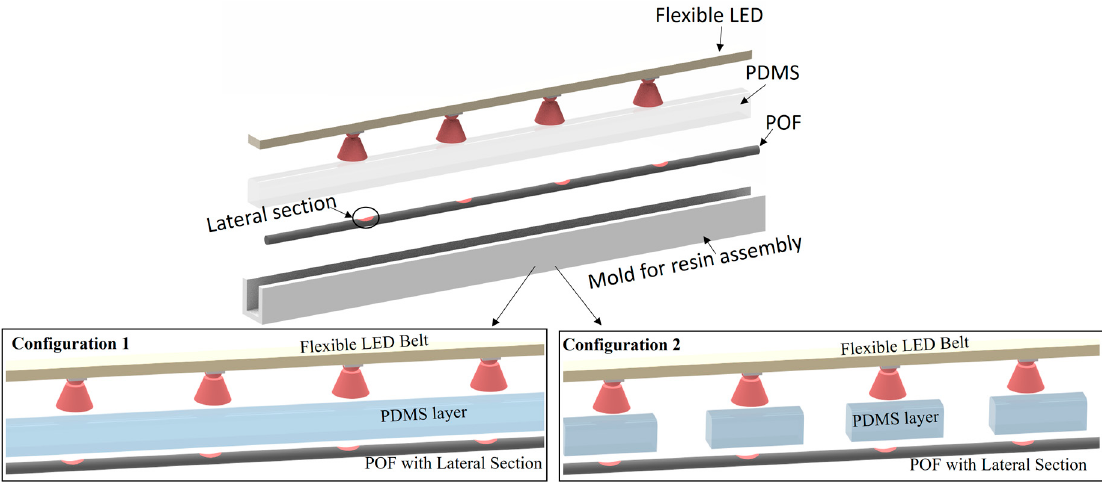
Figure 1. Sensor assembly for each configuration.